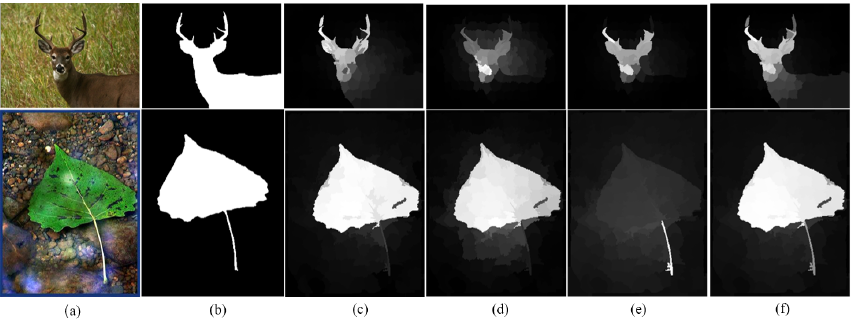
Figure 1. A glimpse of different methods: ( a ) input images; ( b ) ground truth; ( c ) saliency maps using the MFMR method [18] based on color features; ( d ) saliency maps using the method based on low-level features; ( e ) saliency maps using the method based on high-level features; ( f ) our method. Compared with bottom-up methods, deep learning methods have achieved a great level of performance [26–29]. Shen et al. [30] used sparse noise to represent the object regions, and the low-rank matrix represented the background regions. To achieve bet- ter performance, high-level features were incorporated to produce prior maps. Li et al. [31] extracted high-level features from a deep convolutional neural network (CNN) at three different scales. The high-level feature maps and spatial consistency model were applied to each multi-level segmentation. Thus, the refined salient maps were fused into a final salient map. Zhao et al. [32] proposed a deep learning method based on a multi- context with both local features and context. Girshick et al. [33] applied a convolutional neural network to the bottom-up model to locate and segment the